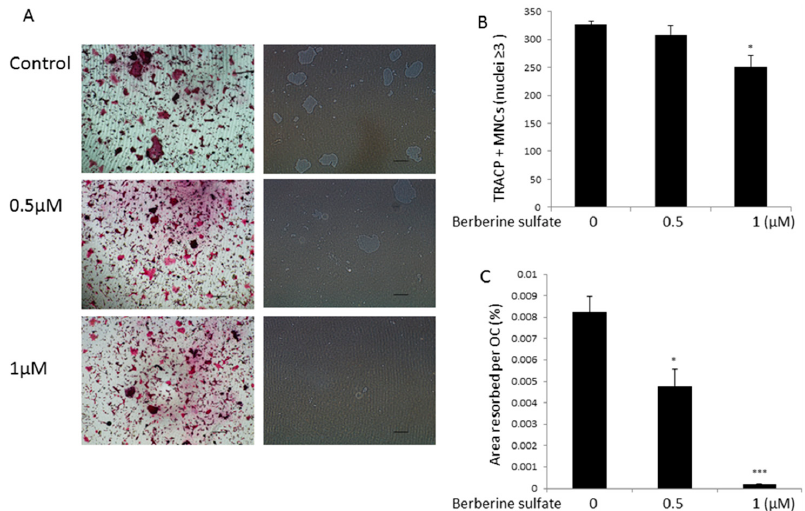
Figure 2. Berberine sulfate suppresses osteoclast function. ( A ) Representative images of osteoclastic resorption and TRAcP staining on hydroxyapatite coated surfaces (Scale bars, 500 μ m); ( B ) The effect of berberine sulfate on the number of TRAcP positive multinucleated cells (Nuclei ≥ 3, counted as osteoclasts); ( C ) Percentage of the area of hydroxyapatite surface resorbed per osteoclast. * p < 0.05, *** p < 0.001 relative to untreated controls.